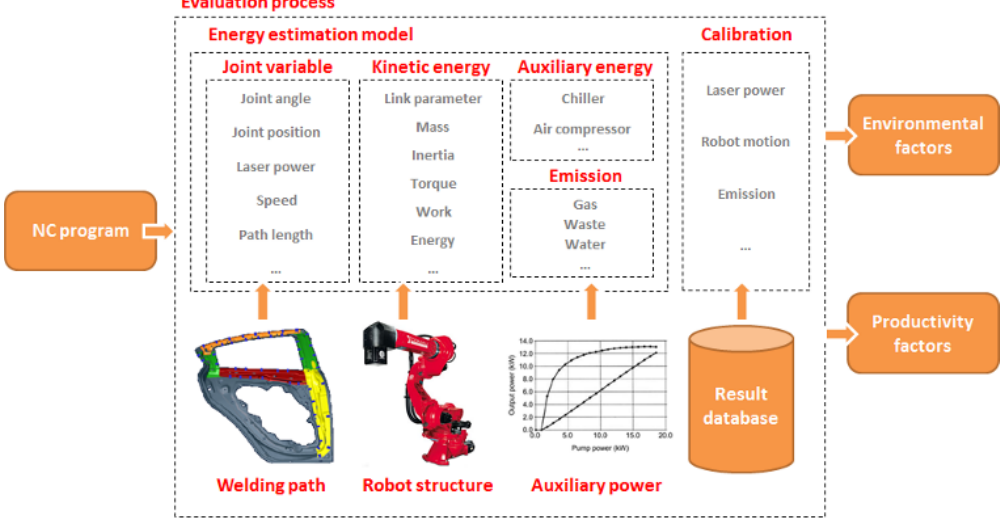
Figure 2. Overall process of the eco-efficiency of the Remote Laser Welding (RLW)